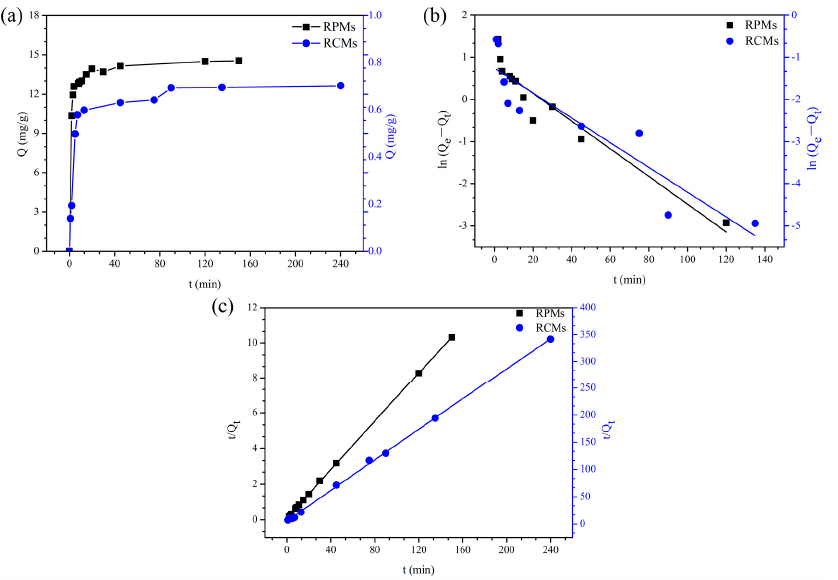
Figure 6. Adsorption kinetics of dencichine on the RCMs and RPMs. ( a ) Adsorption kinetics curves; ( b ) Pseudo-first-order adsorption kinetics model; ( c ) Pseudo-second-order adsorption